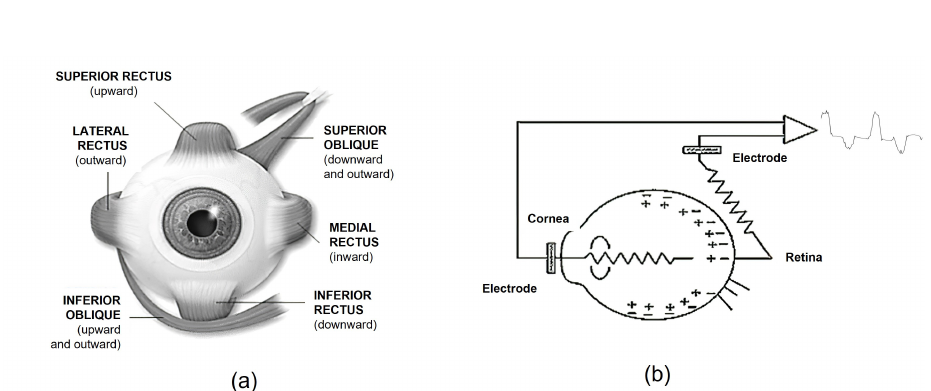
Figure 4. ( a ) Muscles involved in the orientation of the eyeball. Six muscles (per eye) are responsible for generating all movements of the eyes in their bony orbits: Lateral rectus, medial rectus, superior rectus, inferior rectus, superior oblique and inferior oblique. ( b ) Model of the ocular dipole of the EOG registry. Measurement of action potential differential between cornea and